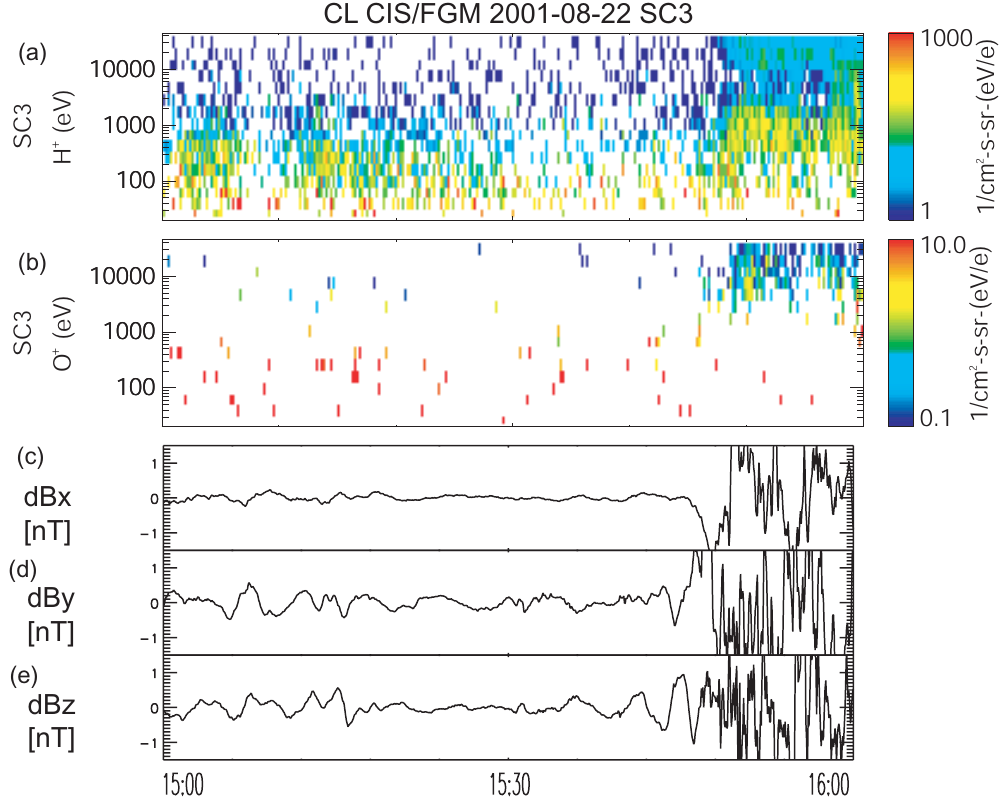
Fig. 6. Cluster SC3 observation on 22 August 2001. Top two panels show energy-time diagrams of (a) proton and (b) O + . (c–e) Magnetic field fluctuations after 10-min moving average subtraction are